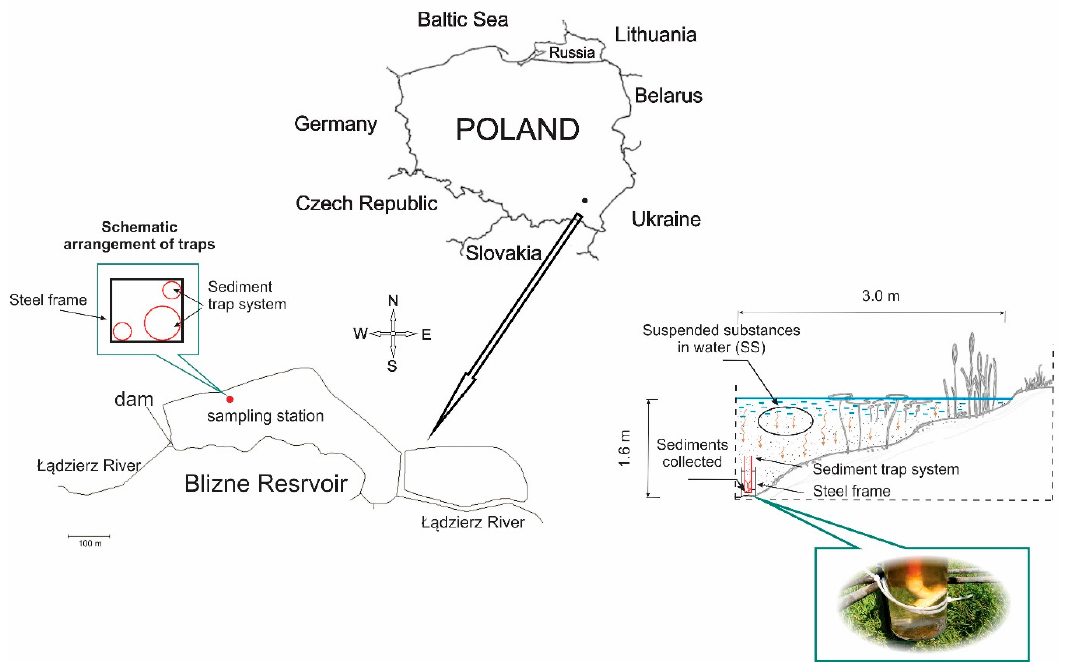
Figure 1. Location of research site, Blizne Reservoir.